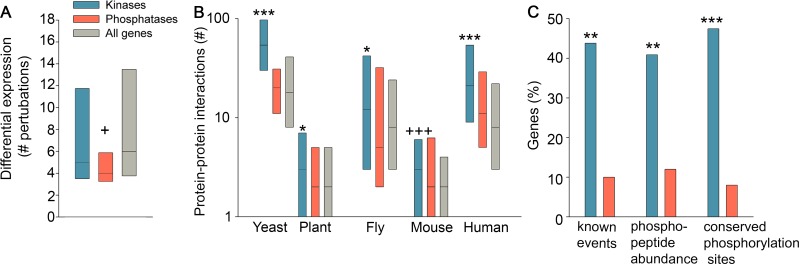
Kinases genes and proteins are more responsive than phosphatases.A. Yeast phosphatases are differentially expressed in fewer perturbations relative to all genes in yeast (p = 0.032, Mann-Whitney test). The data refer to the 45 kinases, 15 phosphatases, and 2979 protein-coding genes that were differentially expressed in at least one perturbation. B. Kinases are significantly more involved in protein-protein interactions (PPIs) relative to phosphatases (*) or to all proteins (+). The numbers of kinases, phosphatases, and protein-coding genes for which PPI data were available, and the respective Mann-Whitney p-value per organism, were as follows: Yeast 135, 49, 4,925, p<10−10; plant 377, 89, 6,430, p = 0.008; fly 213, 85, 9,539, p = 0.032; mouse 311, 52, 5,527, p = 2*10−9; human 633, 177, 16,387, p = 9*10−7. C. The capacity of yeast kinases to undergo phosphorylation is significantly higher than the capacity of phosphatases. This is observed in data of manually-curated phosphorylation / de-phosphorylation interactions (denoted known events), p = 5.7*10−6; in phospho-peptide abundance measurements, p = 9.7*10−5; and in a dataset of conserved phosphorylation sites within protein sequences, p = 1.4*10−7 (Fisher exact test). Box plots show the values at the first, second and third quartiles. ***/+++ indicate p<10−6; ** indicate p<10−3; */+ indicates p<0.05.